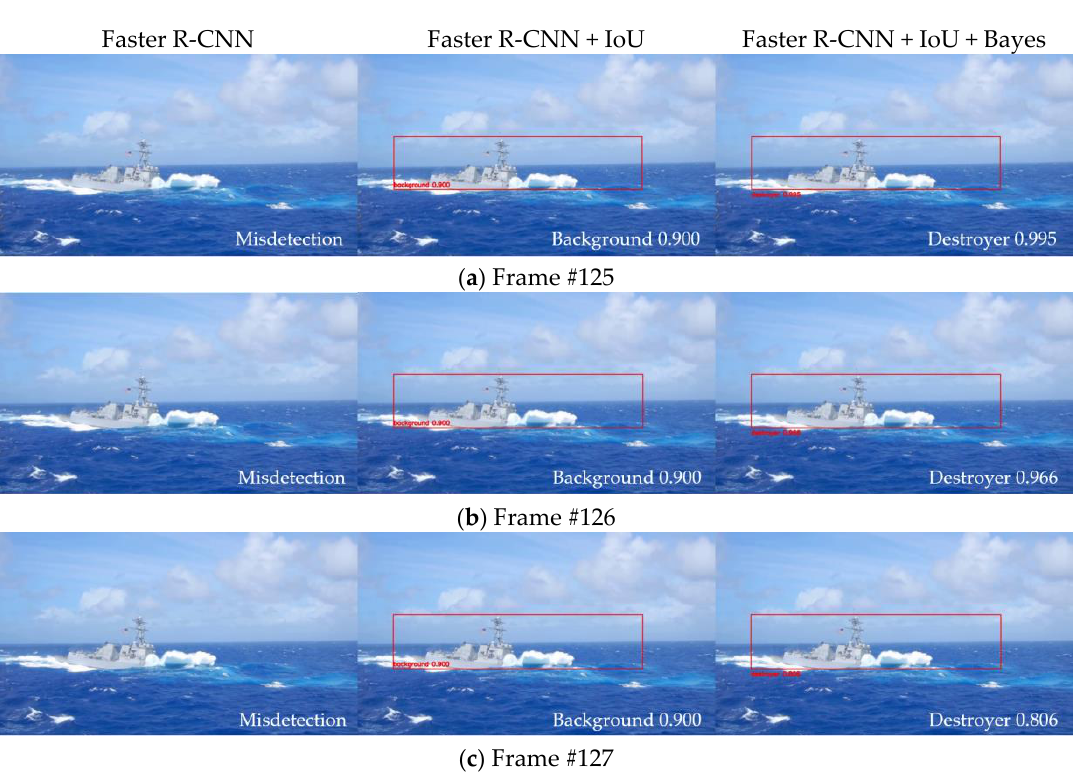
Figure 10. Captured images from Interval 2.